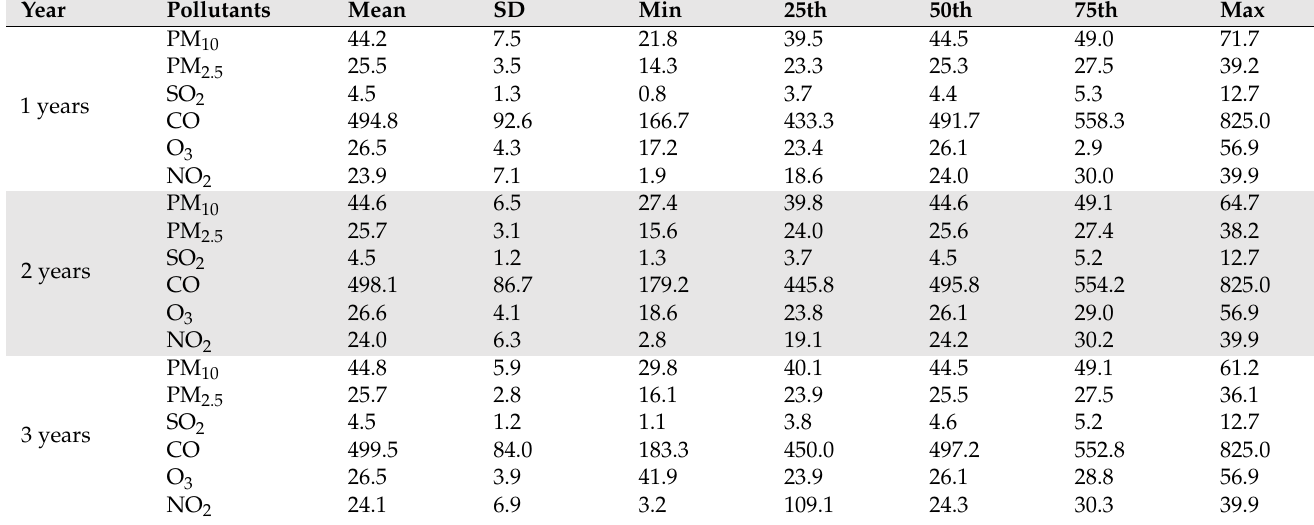
Table 2. Concentration of air pollutants according to exposure